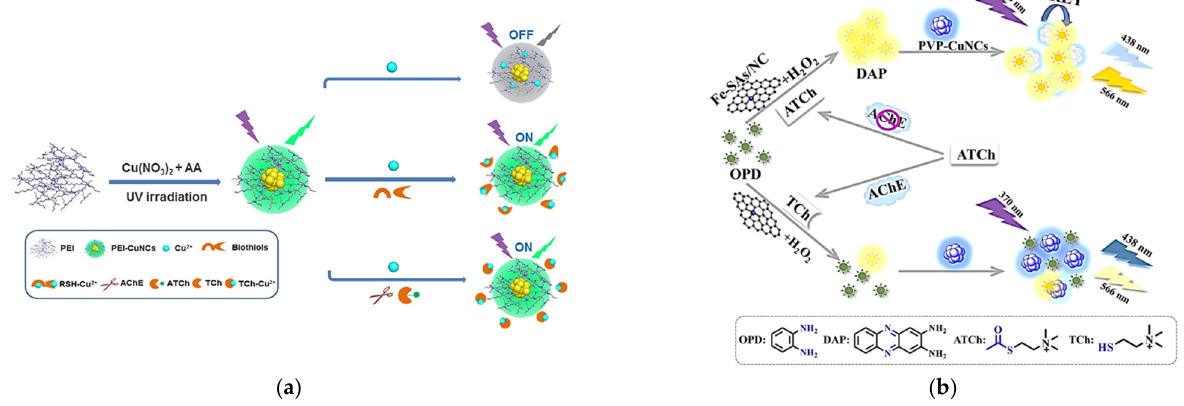
Figure 2. ( a ) Schematic illustration of Cu 2+ -quenched fluorescence turn-on assay for the detection of biothiols and AChE; ( b ) Schematic illustration of this ratio fluorescent sensing strategy for AChE activity sensing.